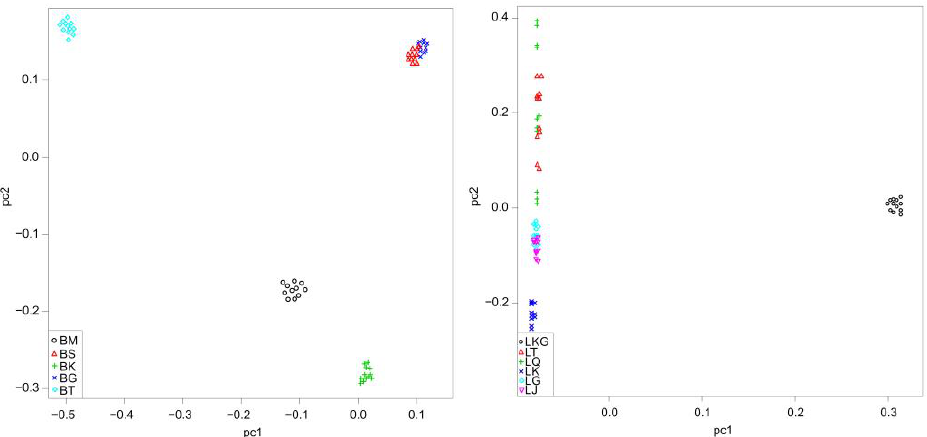
Figure 3. Principal component analysis (PCA) of D. maculates ( left ) and G. dybowskii ( right ) based on genome SNP data. The vertical line represents false discovery threshold of 0.01.